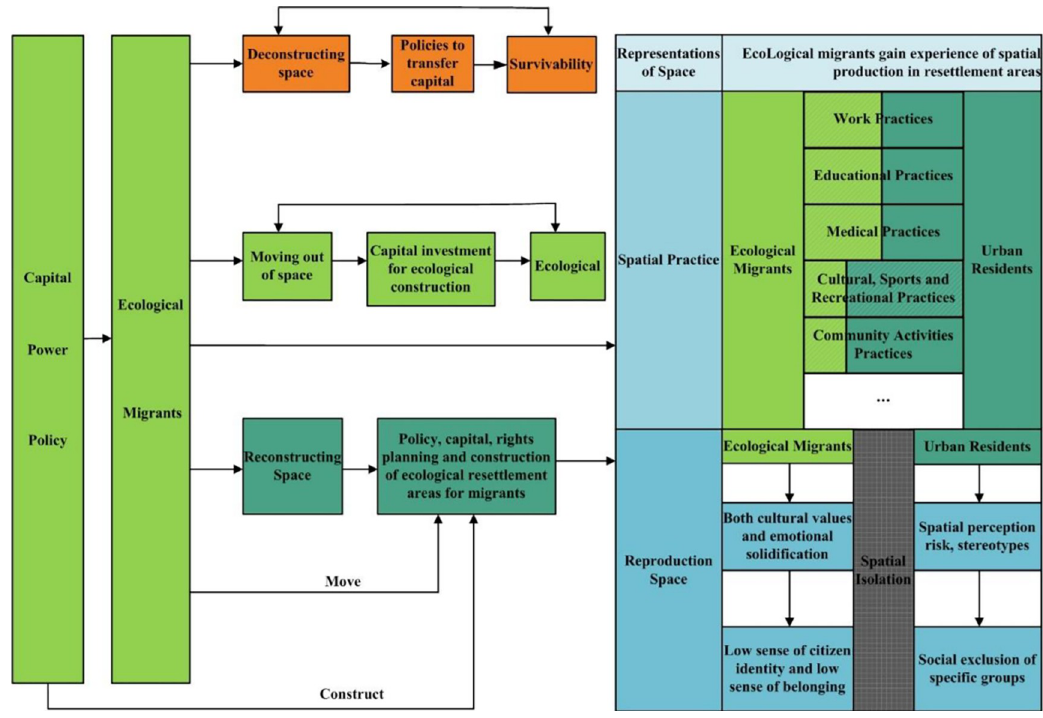
Fig 1. Social space production structure of ecological